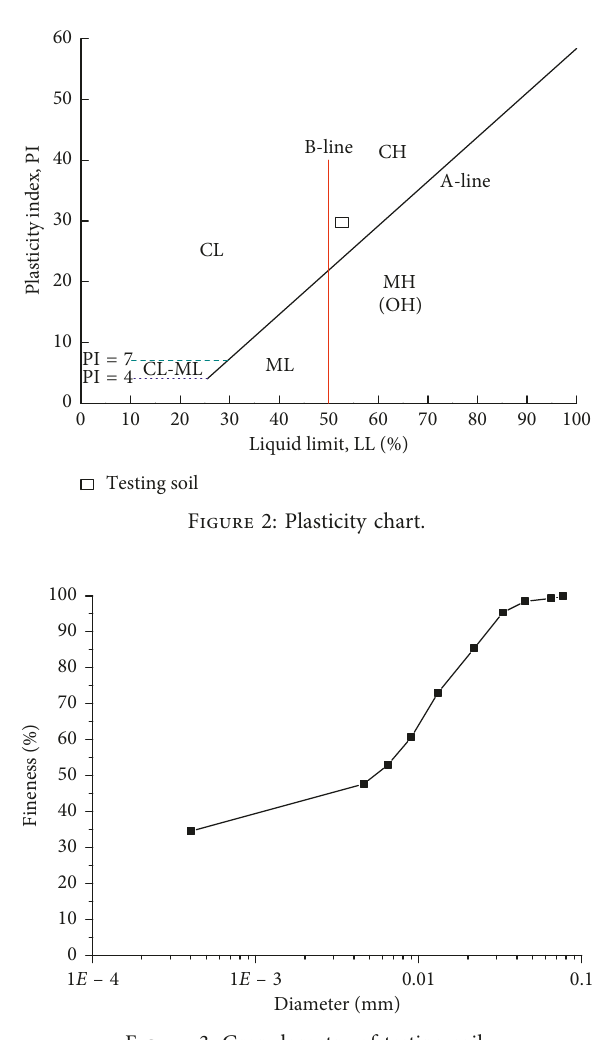
Figure 3: Granulometry of testing